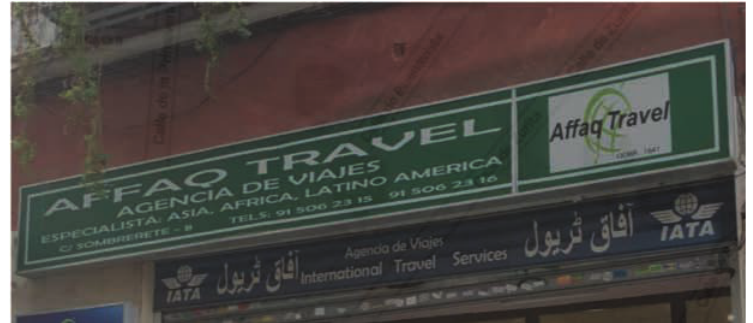
Figure 3: Sample 138 (currently in page 471). As seen in Figure 3, this butcher’s does not specify